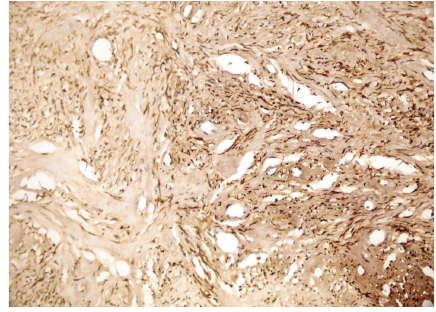
Figure 7: Diffuse bcl-2 staining (bcl-2 ×